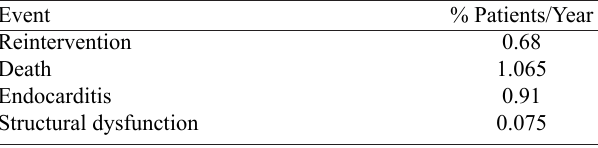
Table 3. Linearized event rates (late outcome).